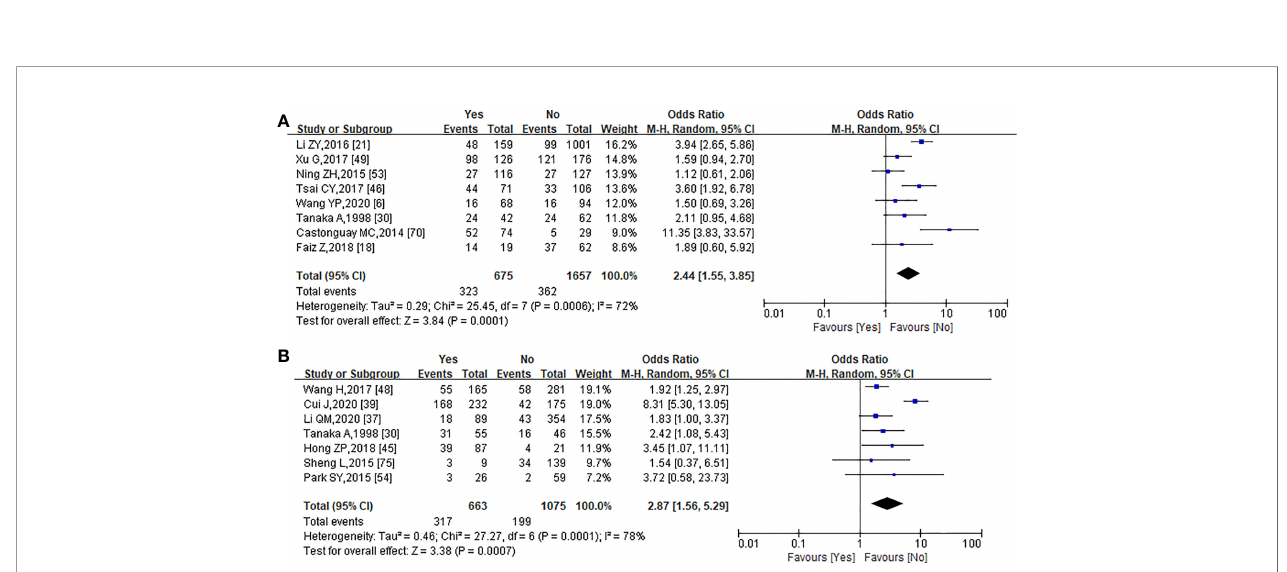
FIGURE 3 | Forest plot analysis of the relationship between PNI and lymphovascularinvasion (A) , and lymph node metastasis (B)